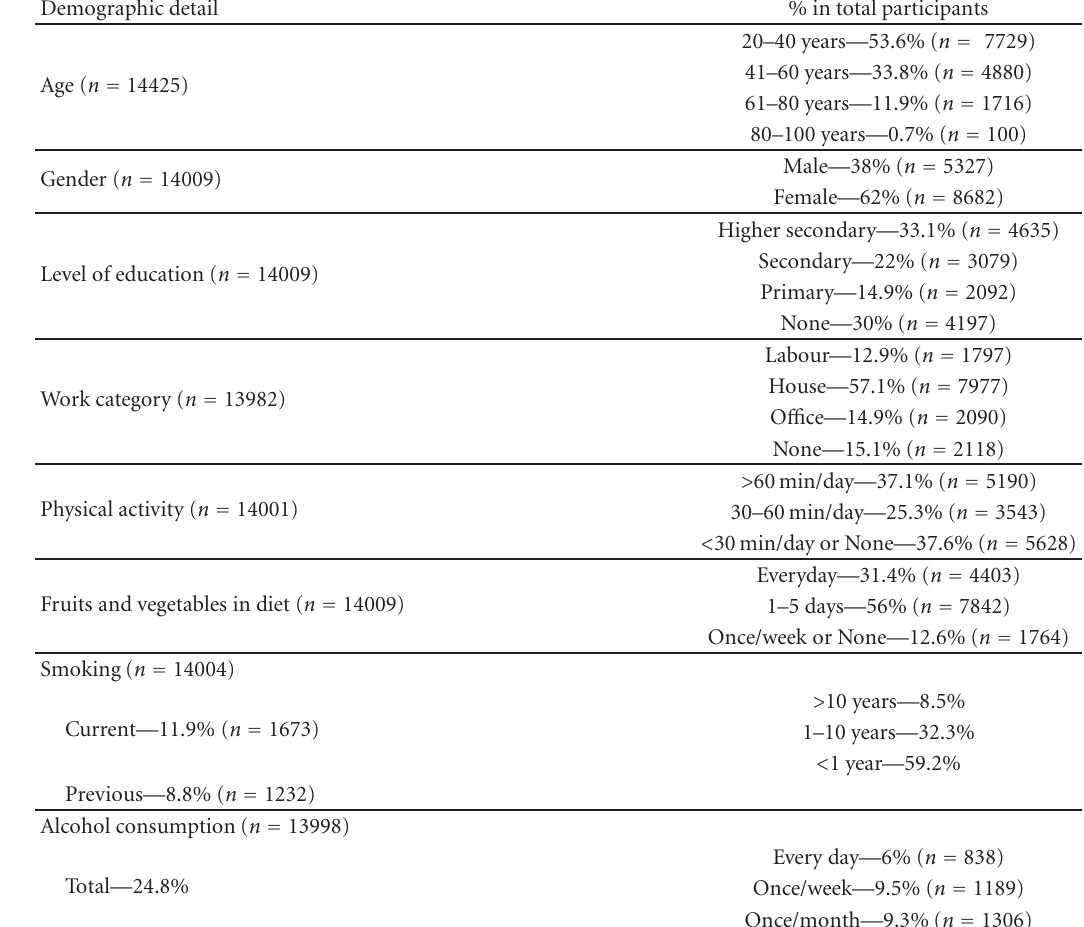
Table 1: Demographic and lifestyle details of the participants.